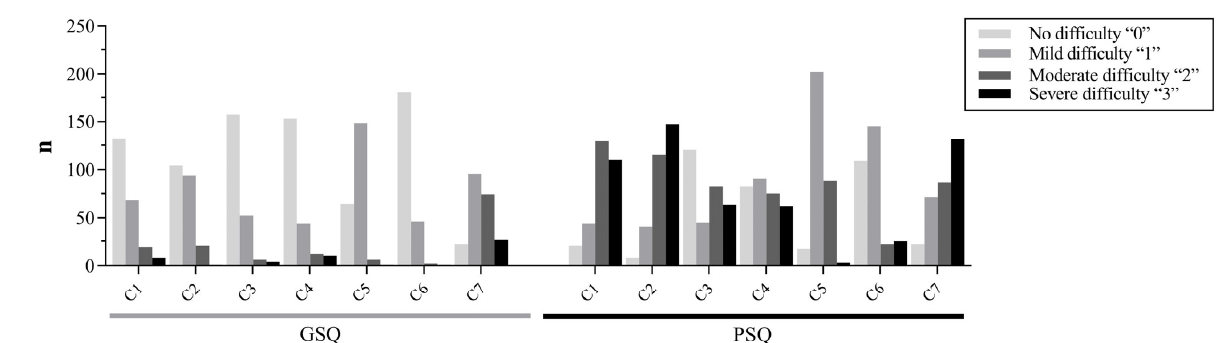
Figure 2. Histogram of the seven components of the PSQI scores for GSQ and PSQ. C1: